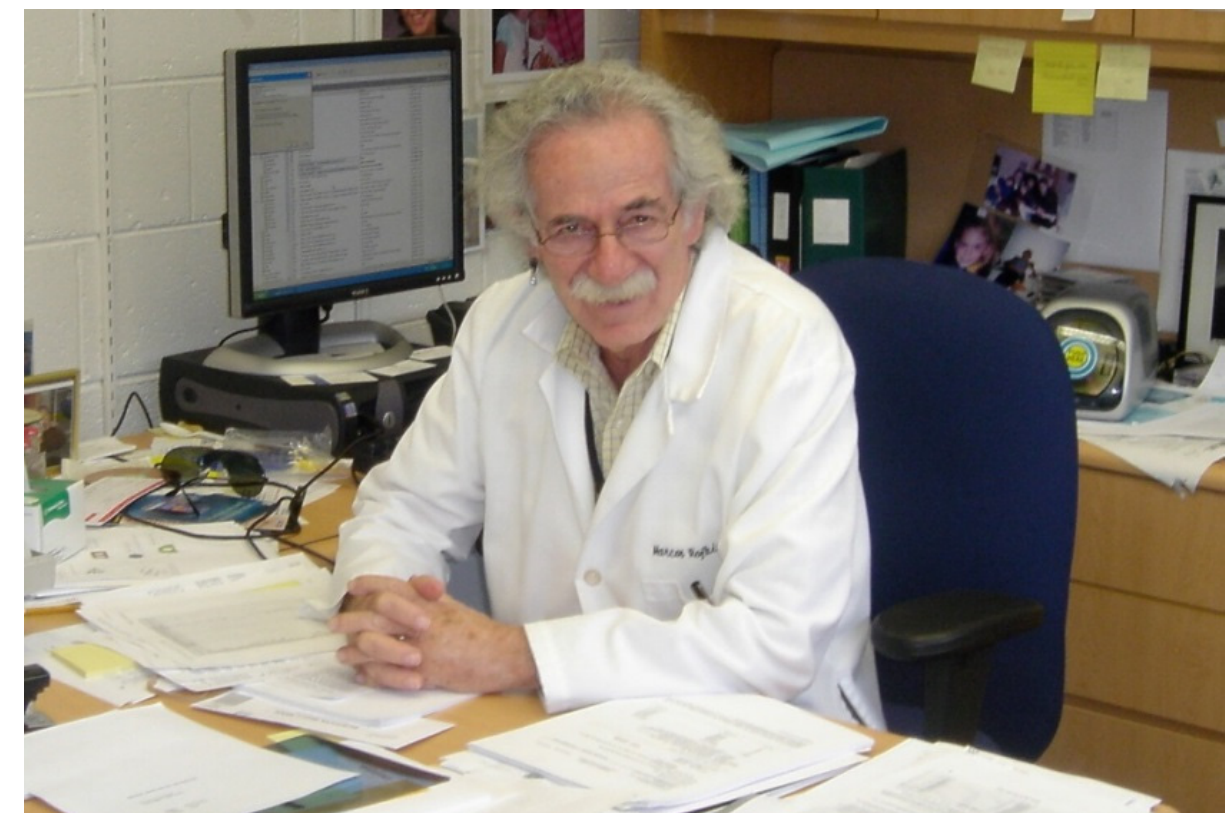
Figure 1. Marcus Rojkind, an outstanding expert in alcohol-induced liver disease research. Marcus